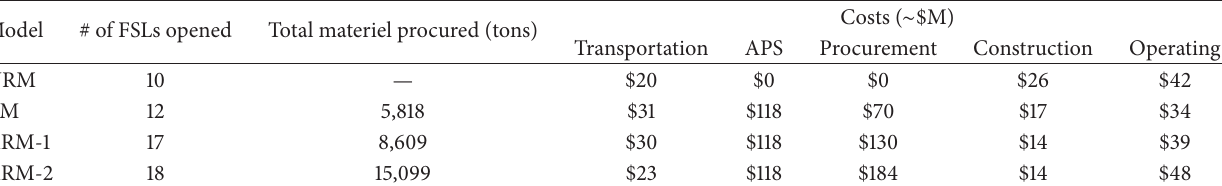
Table 3: Summary of model